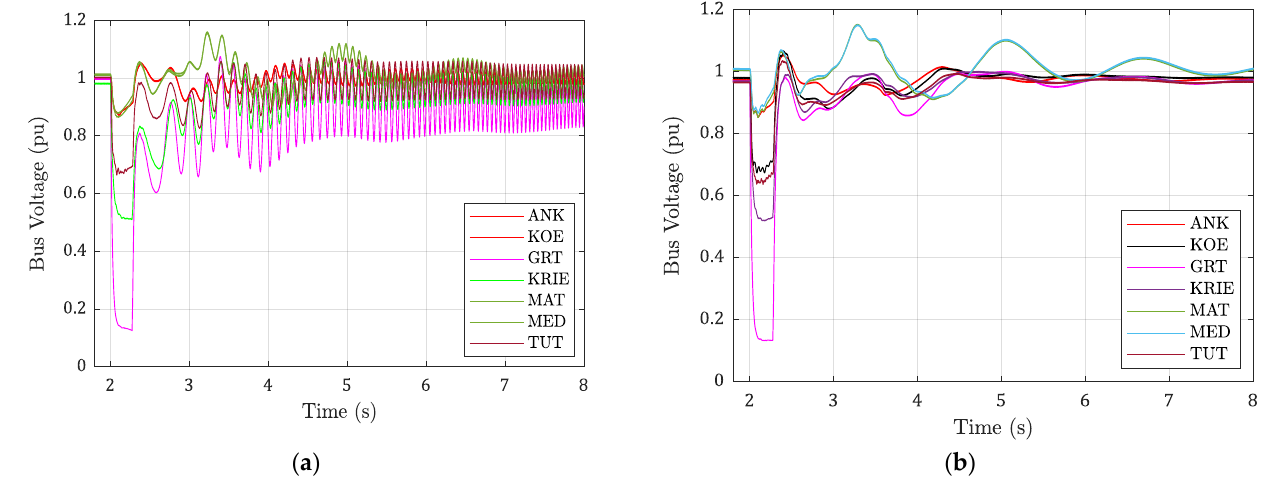
Figure 13. Bus voltage profile ( a ) without the MTDC link and ( b ) with the MTDC link.